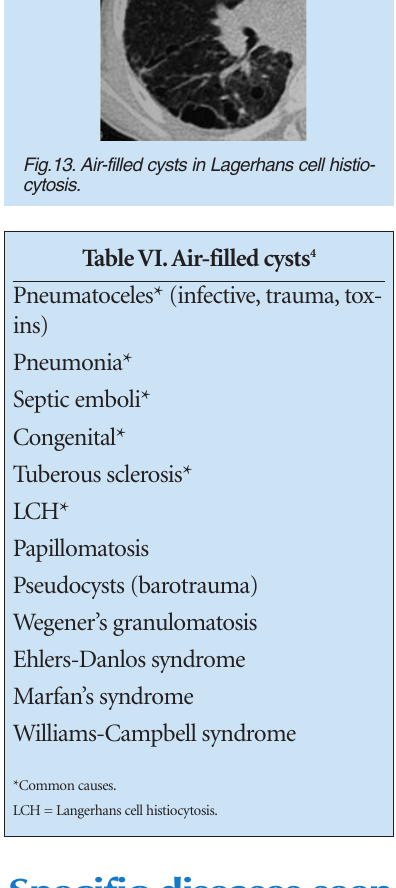
Fig.15. Lymphoid interstitial pneuomonitis.